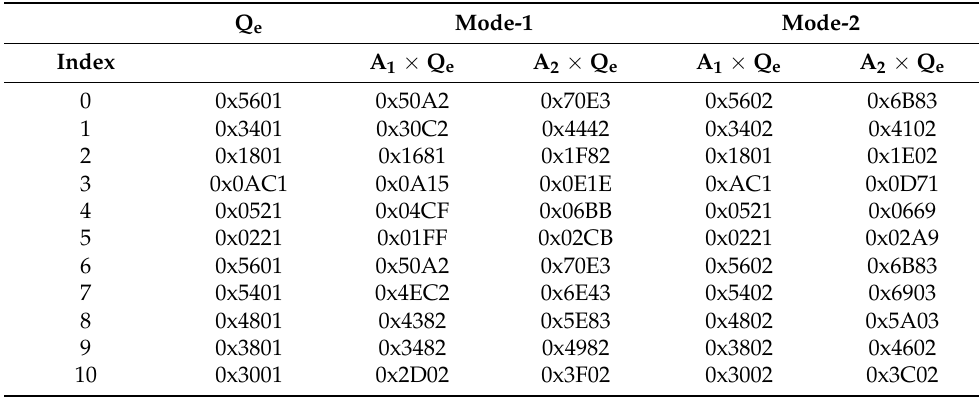
Table 4. Two modes of 2-level lookup tables for (A i × Q e ) (47 × 2, α = β =